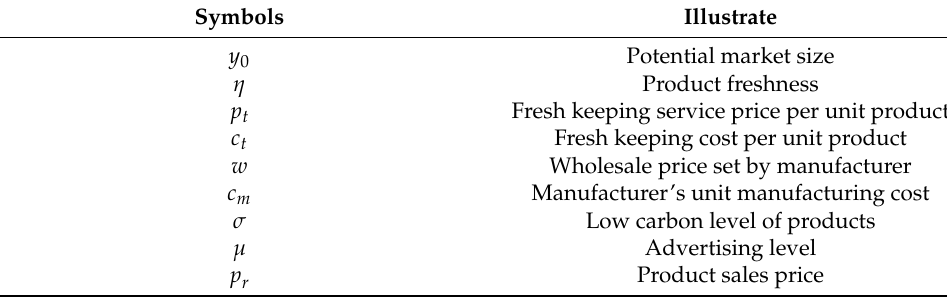
Table 2. Description of relevant parameters and